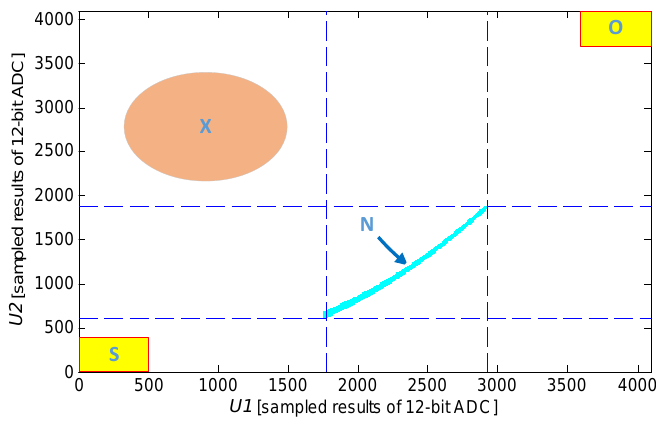
Figure 10. Built-in self-test vector